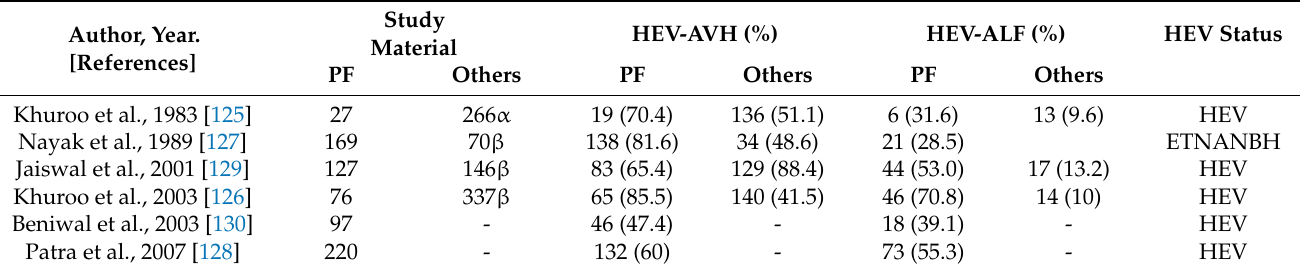
Table 2. Prevalence of HEV infection among pregnant women with acute sporadic viral